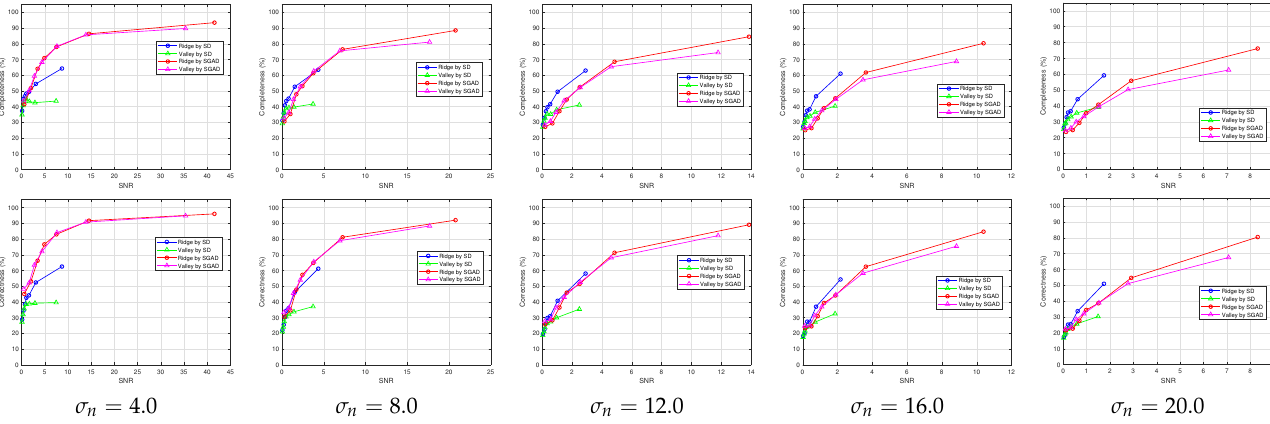
σ n = 4.0 σ n = 8.0 σ n = 12.0 σ n = 16.0 σ n = 20.0 Figure 12. Completeness and correctness against SNR for the Lena image under varying σ n . Top row shows completeness and bottom row correctness.